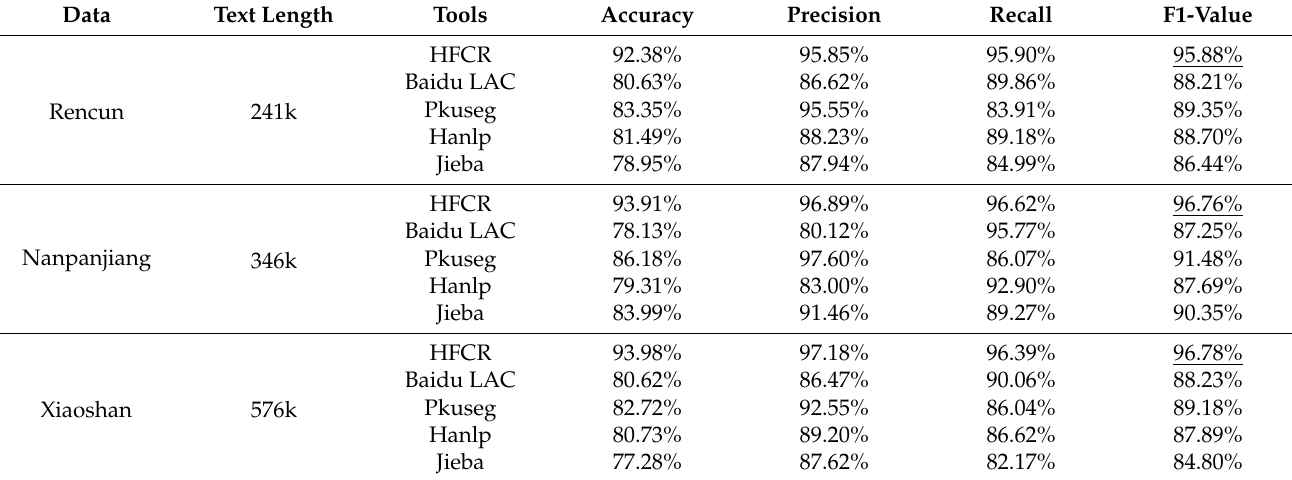
The underlined part indicates the optimal segmentation performance.